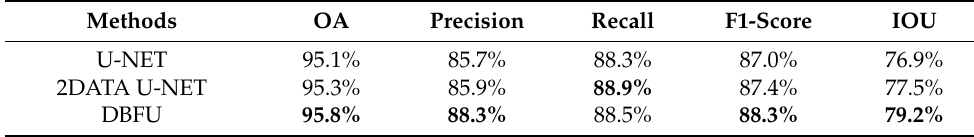
Table 4. Comparison of the accuracy of U-NET, 2DATA U-NET and